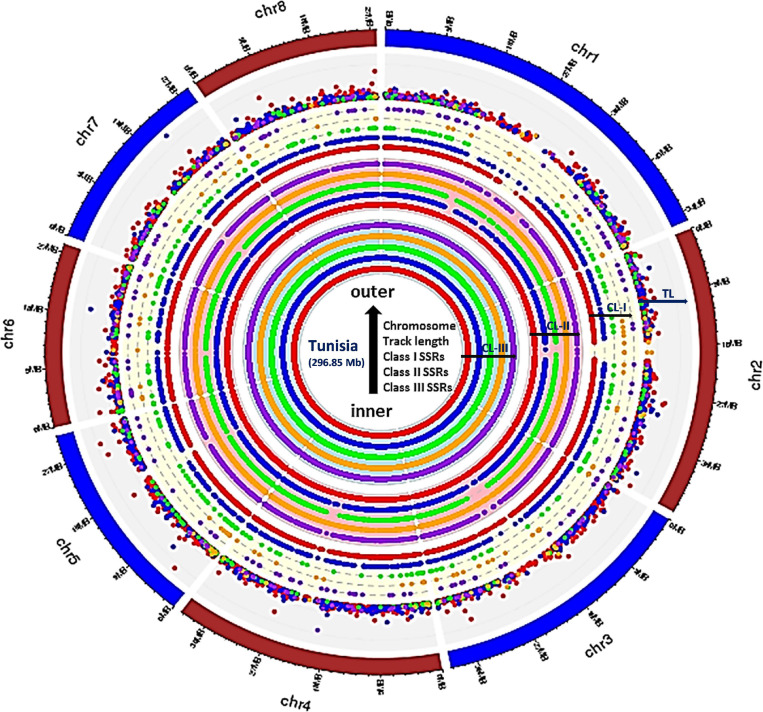
Circos graph depicting the chromosome-wide distribution for three major classes of perfect SSRs (excluding mononucleotides). Inner ring represents class III, whereas middle and outer rings correspond to class II and class I, respectively, and the densely placed colored dots depict the tract length for each motif types. All rings from inside to outside have five subrings representing, di-, tri-, tetra-, penta-, and hexanucleotides with color codes red, blue, green, orange, and purple, respectively. The densely placed spots in the outer ring represented tract length variations for each repeat motif with specific color code. The di (red spots) and tri (blue spots) showed maximum variations which can be exploited for designing chromosome-specific hypervariable SSR markers.